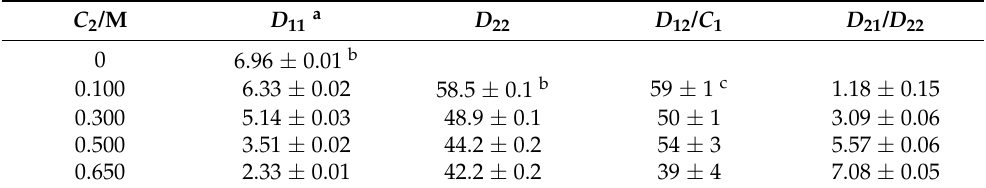
Table 1. Ternary diffusion coefficients, D ij , at 25 °C for the tyloxapol–MgSO 4 –water system and tyloxapol molar concentration of C 1 = 1.00 mM.